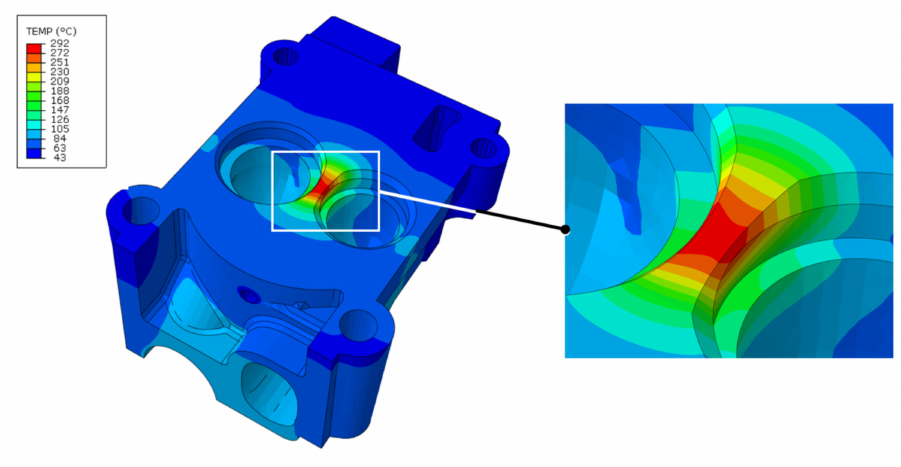
Figure 15. Single-cylinder specimen thermal computation and thermal gradient